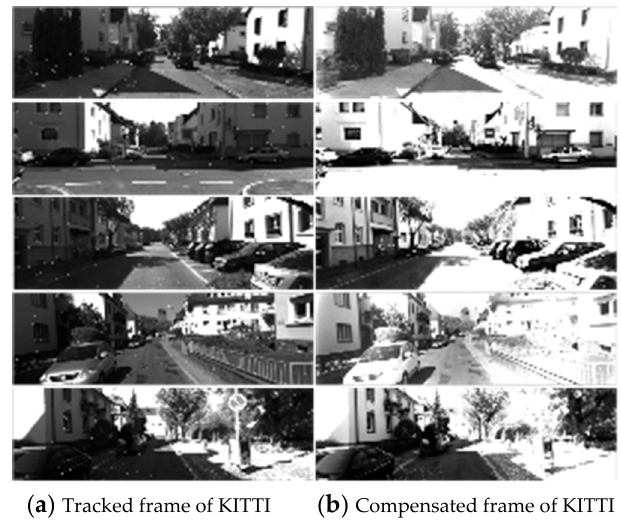
Figure 3. The partial photometric calibration results of KITTI sequence 00. The subfigures ( a ) are the tracked original frames, and the subfigures ( b ) are the compensated frames. It can be seen in subfigure ( b ) that the global exposure was enhanced, especially at the edge of the image. In addition, the brightness values of subfigure ( b ) remained continuous.